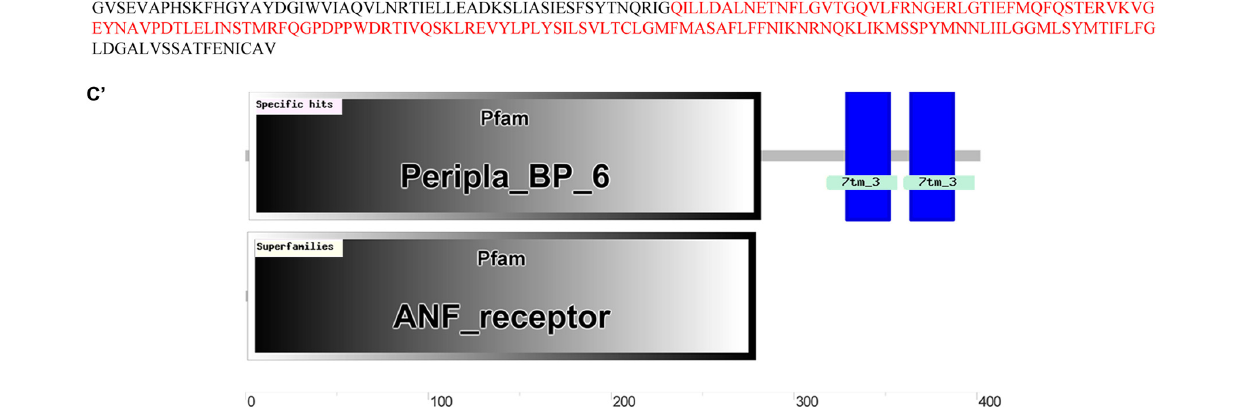
FIGURE 1 | Partial cDNA sequences of the GABA B1 (A) and GABA B2 (A (cid:48) ) subunits from the Ensembl database, with the cloned sequences marked in red. Sequences of the deduced GABA B1 (B) and GABA B2 (B (cid:48) ) proteins with the sequence corresponding to the cloned cDNA sequences highlighted in red. Analyses of the predicted GABA B1 (C) and GABA B2 (C (cid:48) ) proteins in SMART and Basic Local Alignment Search Tool (BLAST).